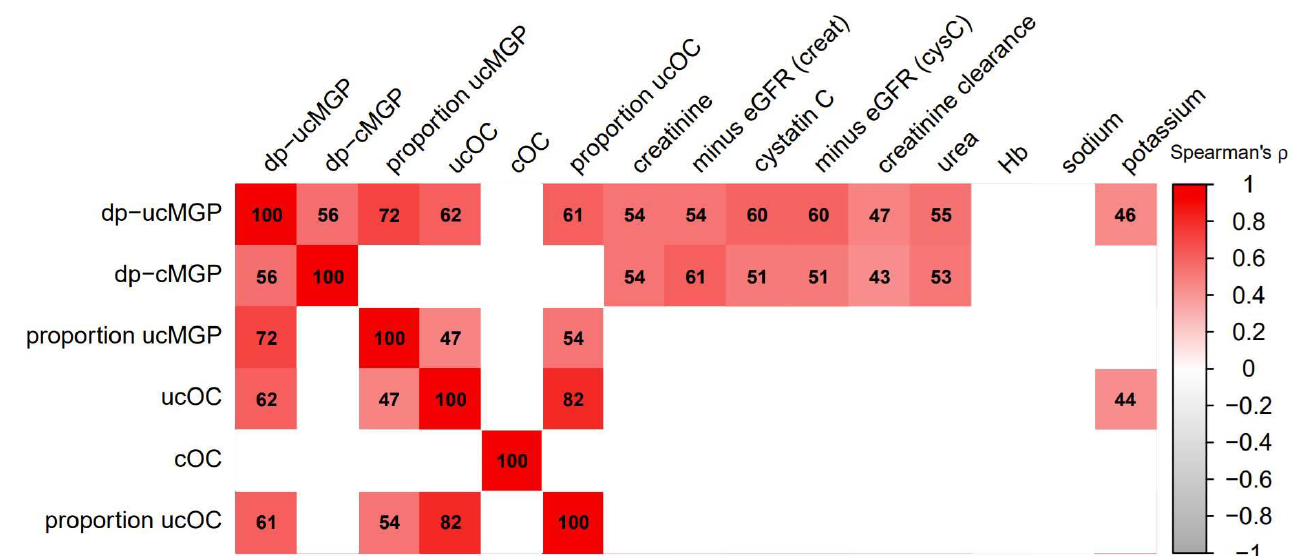
Figure 3. Correlation heat map of vitamin K-associated and kidney function-associated parameters, in a subgroup of 60 kidney transplant recipients from cohort 1. Numbers indicate Spearman’s rank-based coefficients multiplied by 100. p -values were multiplied by 90 to adjust for multiple testing (following the Bonferroni method), and the tiles of insignificant correlations are blanked. Abbreviations: dp, dephosphorylated; eGFR, estimated glomerular filtration rate; MGP, matrix Gla protein; OC, osteocalcin; (u)c, (un)carboxylated.